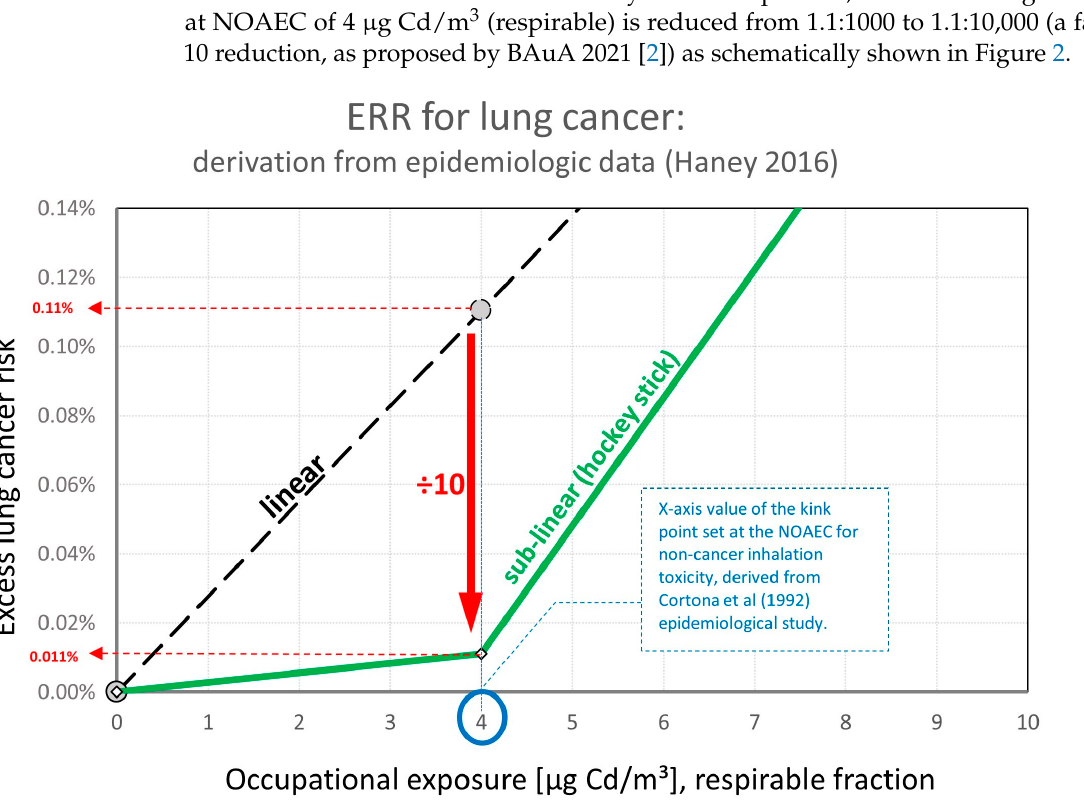
Figure 2. Exposure Risk Relationship (ERR): derivation based on epidemiological data Haney 2016